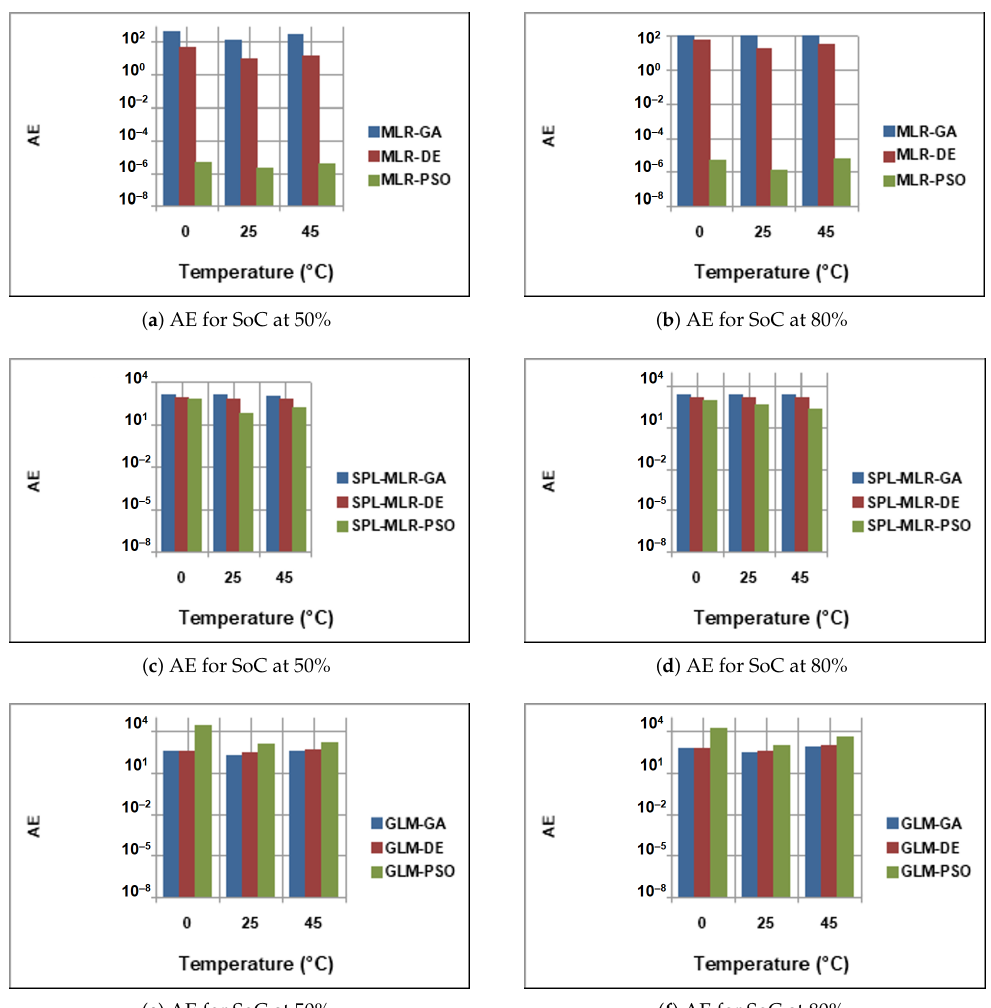
Figure 7. General comparison among models for the US06